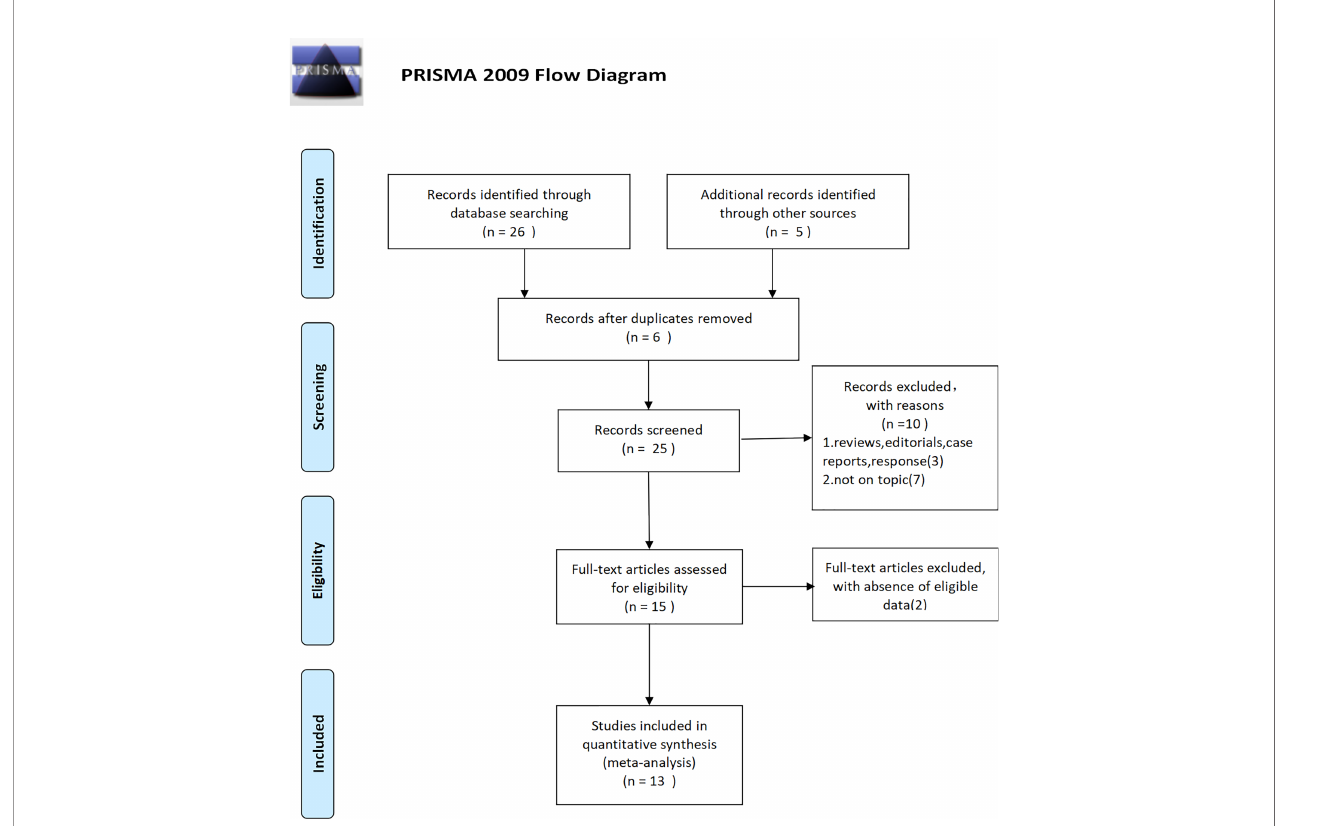
FIGURE 1 | Flow chart of study